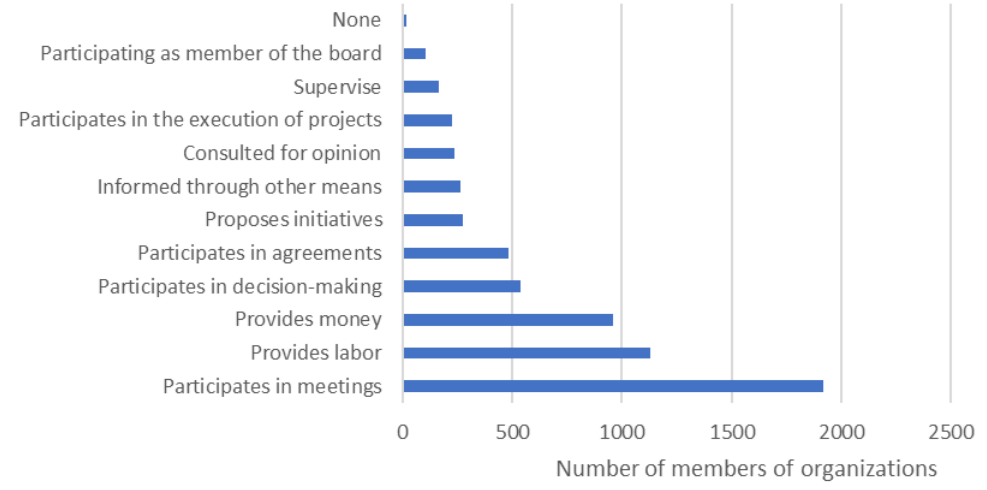
Figure 9. Activities carried out in the organization.